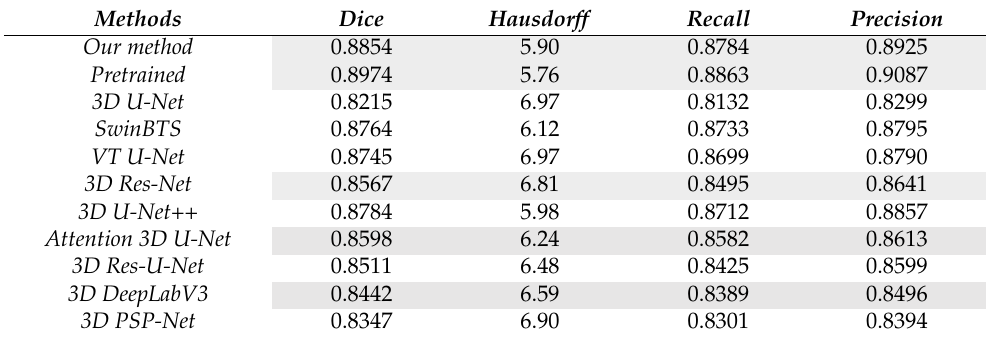
Table 1. Comparison results with other existing methods.